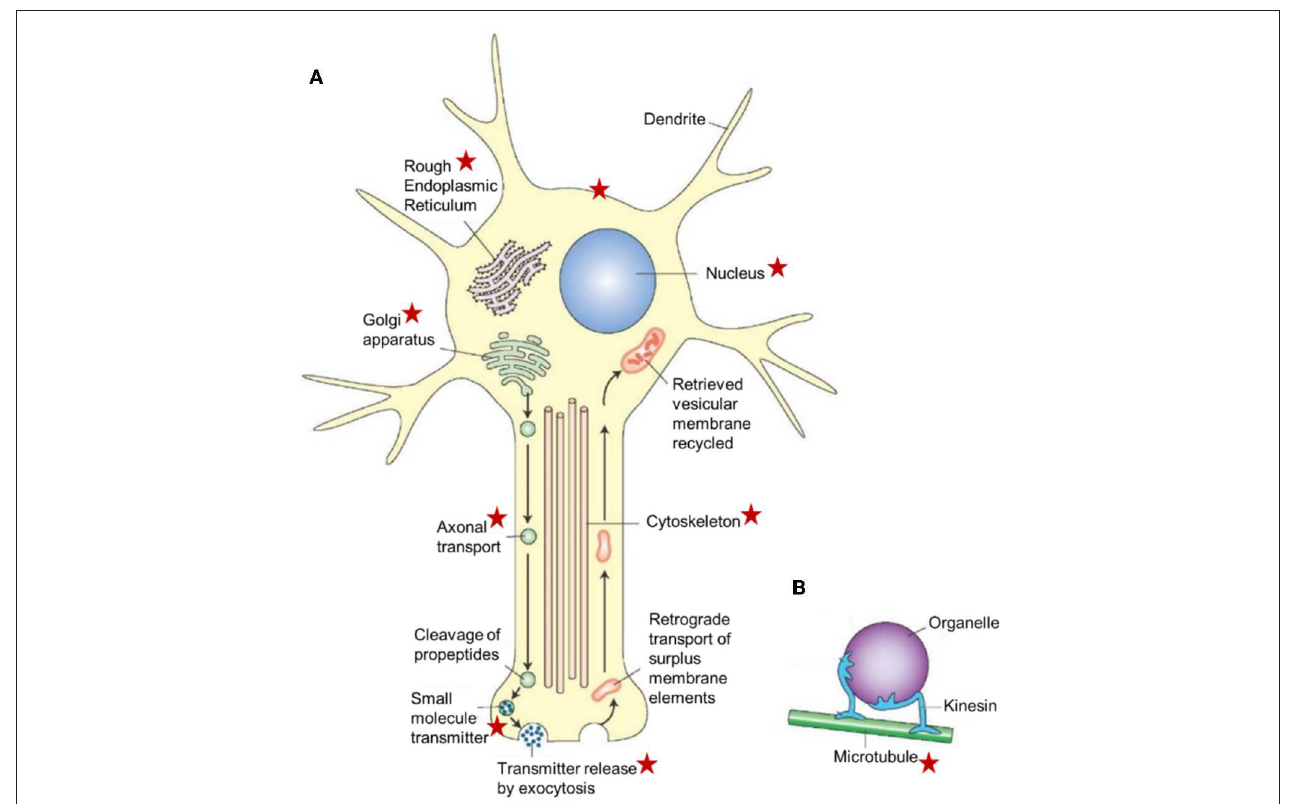
FIGURE 7 | Schematic representation of a neuron illustrating the major cellular sites and cell organelles that are influenced by endogenous farnesol-like sesquiterpenoids, as highlighted by the red asterisks. This list is not exhaustive (e.g., the figure does not list the mitochondria which are known targets of farnesol/JH). The functional relation between farnesol/FLS and the Ca 2 + -homeostasis system with its numerous actors, explains why there are so many target sites. This figure is combinatorial: the asterisks represent data from different experimental models. The basic idea underlying this figure is also valid for other cell types, in particular for those with an active RER-Golgi system. This figure, borrowed from Google pictures, specifically focuses on axonal transport. (A) Large peptide molecules (pre-propeptides) are converted into smaller peptides (propeptides) in the rough endoplasmic reticulum. The propeptides and enzymes are packaged into vesicles that are transported to the Golgi apparatus, modified, and packaged into vesicles. The vesicles get attached to microtubules and are carried to the terminals by fast axonal transport. The propeptides are cleaved into smaller peptidergic transmitters in the axon’s terminal. The peptide neurotransmitters are released into the synaptic cleft by exocytosis. Surplus membrane elements in the terminal are carried back to the cell body by retrograde transport. The retrieved vesicular membrane is degraded or recycled. (B) A model showing how kinesin (a microtubule-associated ATPase) can move an organelle along a microtubule. Copyright information: This figure is listed in Google Images, without specific information on the authors, only general information. From: What-when-how; In Depth Tutorials and Information; Histology of the Nervous System (The Neuron) Part 1, The Neuron figure 5-2. With thanks to the anonymous author(s). For lack of information, Open Access is